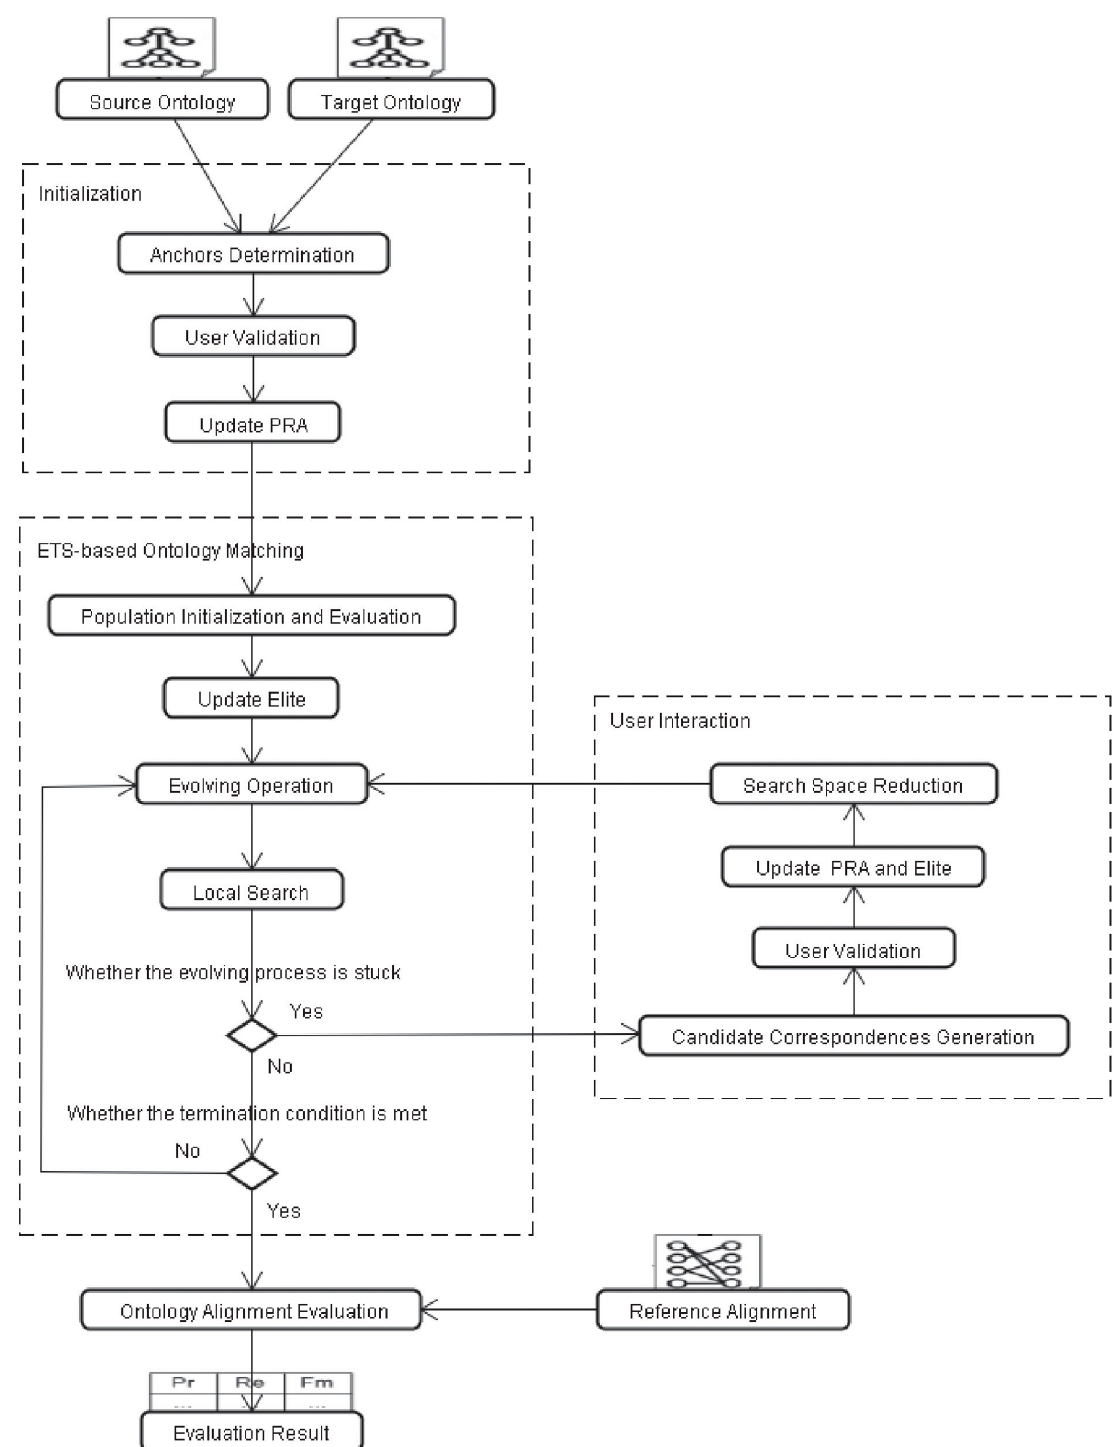
Fig 1. Interactive biomedical ontology matching